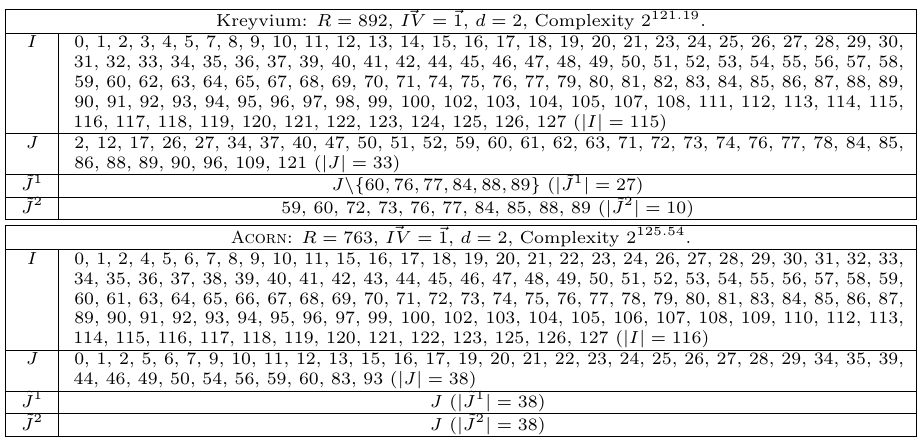
Table 6: The detailed parameters for our improved attacks on 892-round Kreyvium and 763-round Acorn